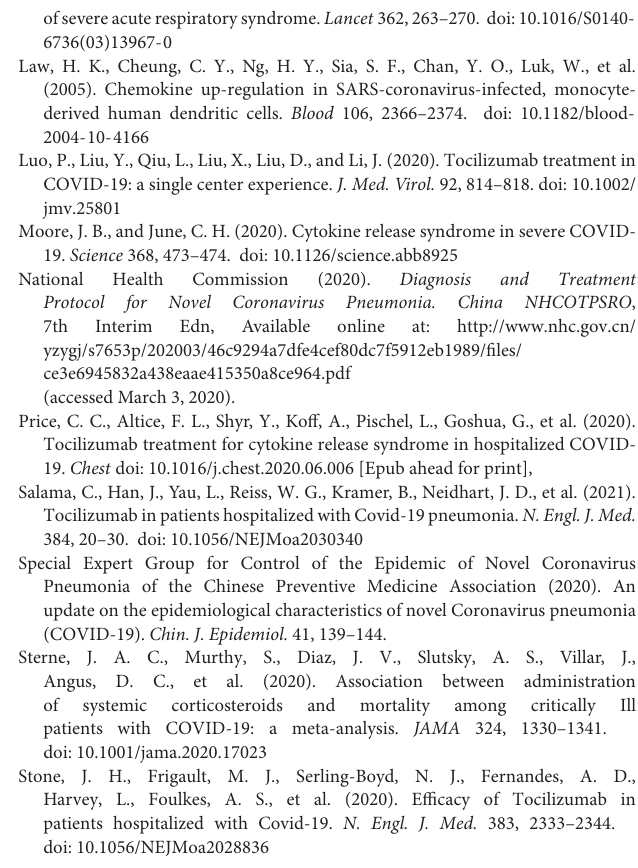
Supplementary Figure 1 | Survival analysis with Kaplan–Meier curves between baseline laboratory examination groups. (A) Il-6, using the median value of 30 pg/ml as cut-off value; (B) Il-6, using the median value of 50 pg/ml as cut-off value. Supplementary Figure 2 | Multivariable Cox proportional-hazards model analysis used to explore the role of tocilizumab on clinical outcomes when adjusted for clinical covariates, including age, Bmi, diabetes, and administration of